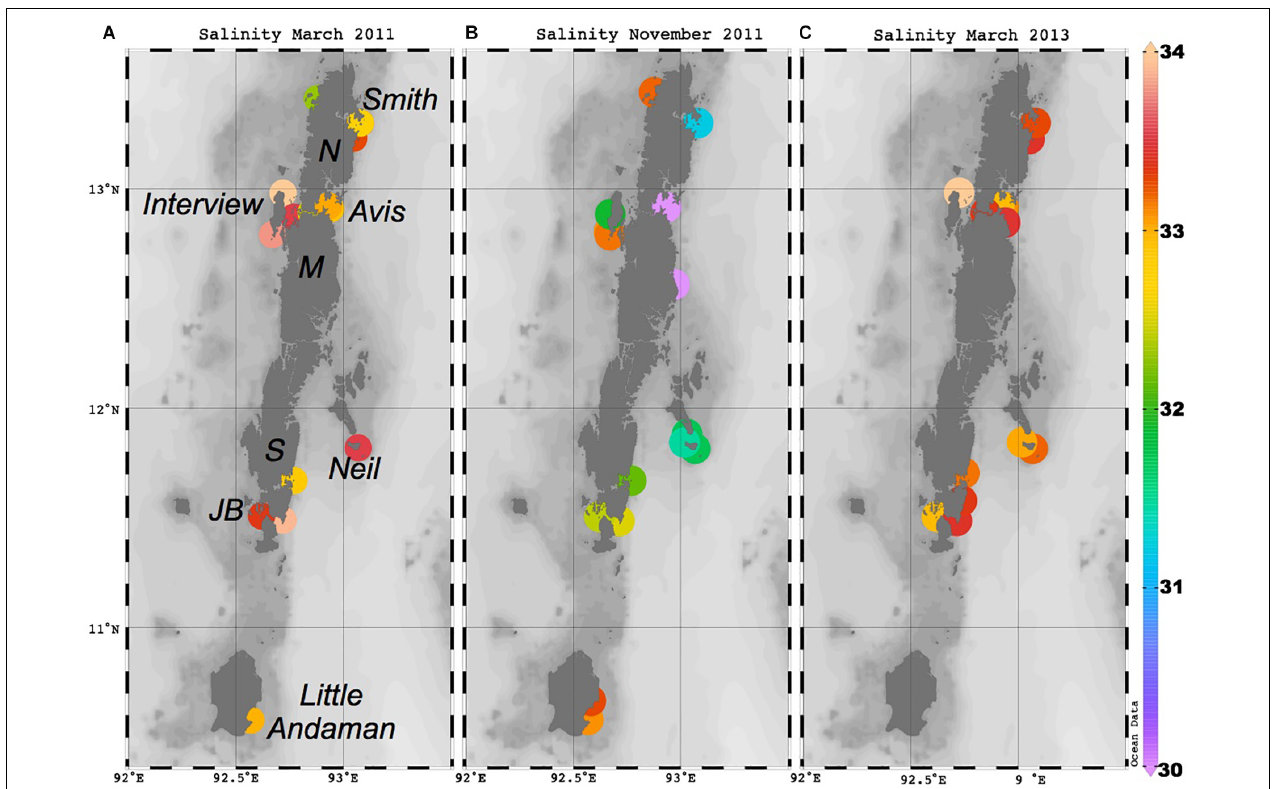
FIGURE 2 | Maps of sample salinity during sampling in (A) March 2011, (B) November 2011, and (C) March 2013. The locations of islands mentioned throughout the text are shown. N = North Andaman, M = Middle Andaman, S = South Andaman, JB = Jolly Buoy. This figure was made using Ocean Data View (Schlitzer, R., Ocean Data View, http://odv.awi.de,